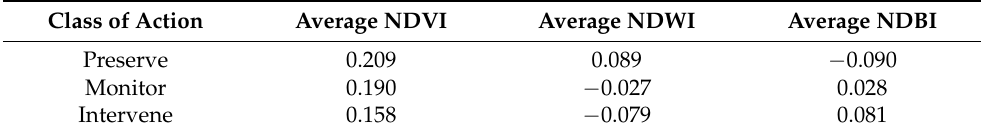
Table 13. Average values of LULC indicators per IUHI class of action. Class of Action